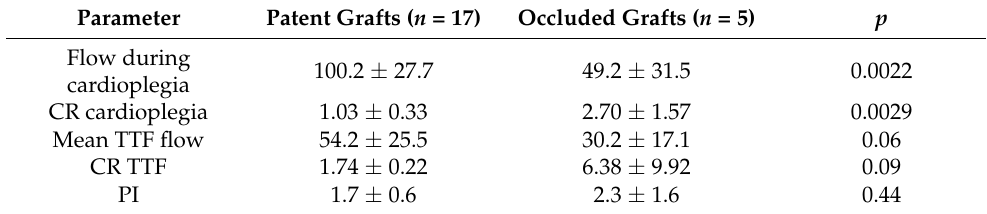
Table 3. Differences in graft flowmetry and its derivatives between patent and occluded grafts.